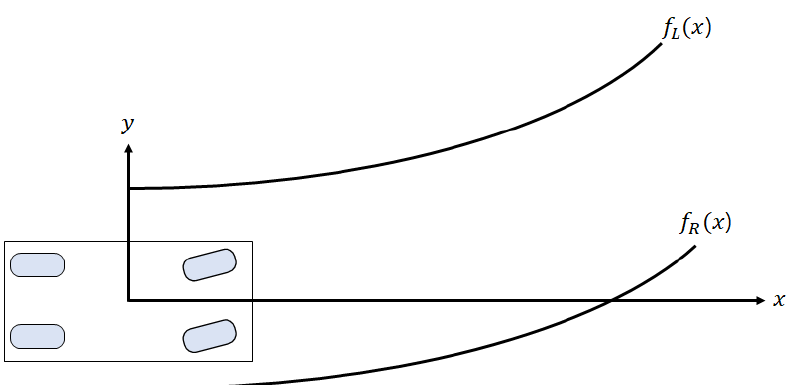
Figure 13. Example of lane marking